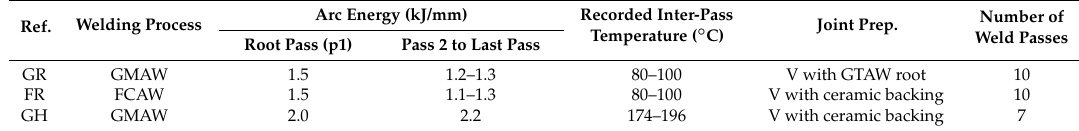
Table 2. Designation and chemical composition of the plate and the fillers. For GTAW and GMAW, it refers to the wire composition, whilst for FCAW it refers to the all-weld composition (wt %).